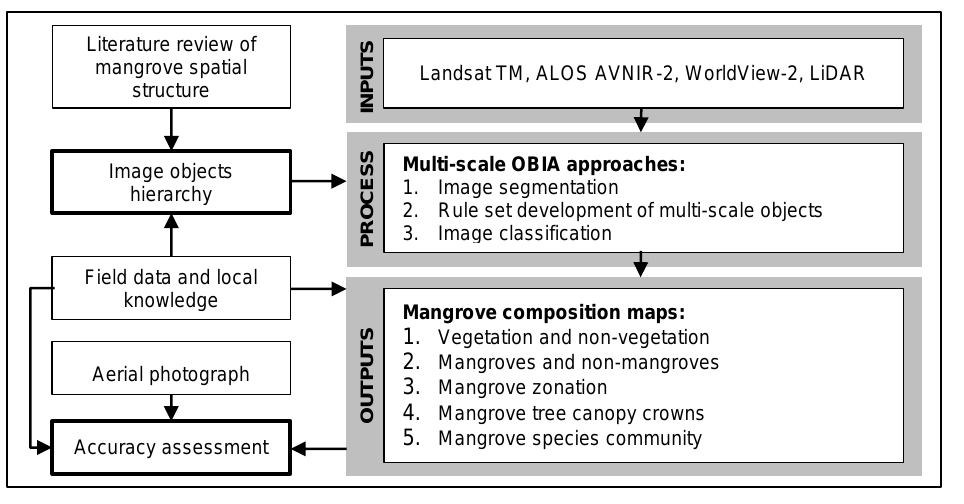
Figure 3. Flowchart of the mapping process applied in this